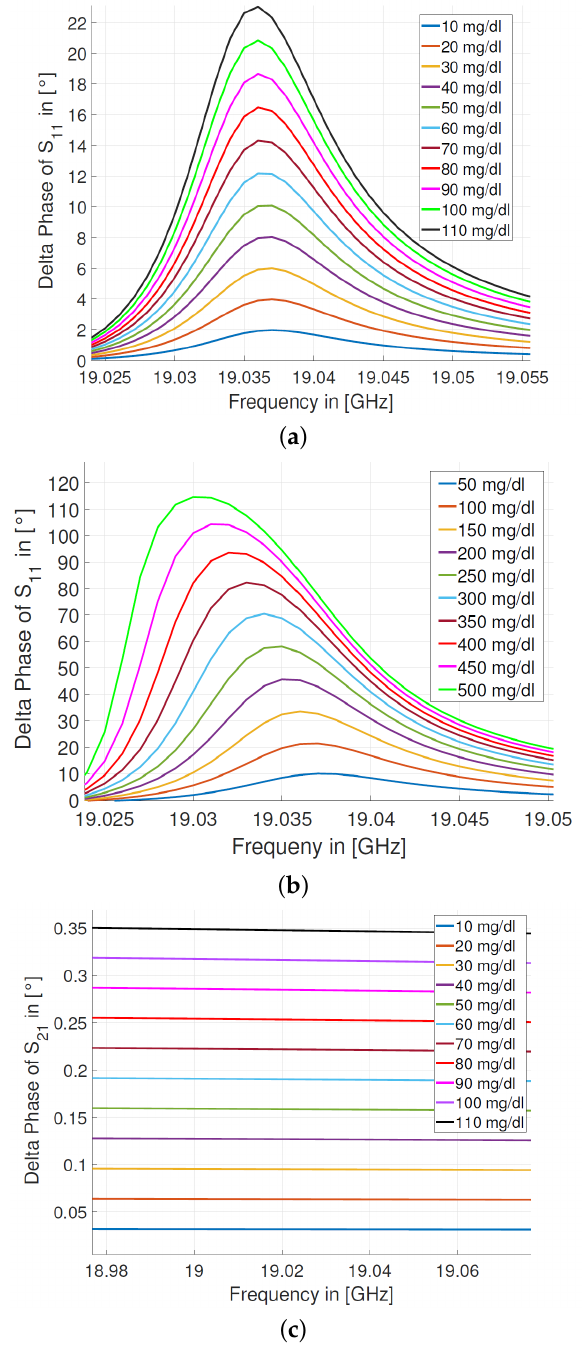
Figure 11. Phase variation of S 11 and S 21 due to the different glucose concentrations (Reprinted with permission from Ref. [98] © 2020 IEEE). ( a ) Phase variation of S 11 with a glucose concentration of 10–110 mg/dL. ( b ) Phase variation of S 11 with a glucose concentration of 50–500 mg/dL. ( c )